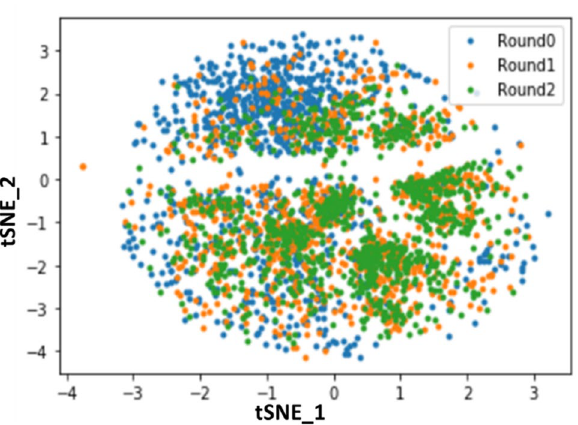
Figure 3. Visualization of doc2vec embedding of VH sequences by t-SNE (k-mer: 3, window size: 4, dimension: 256). Each sequence was plotted with blue (before panning), orange (one round) and green (two round).